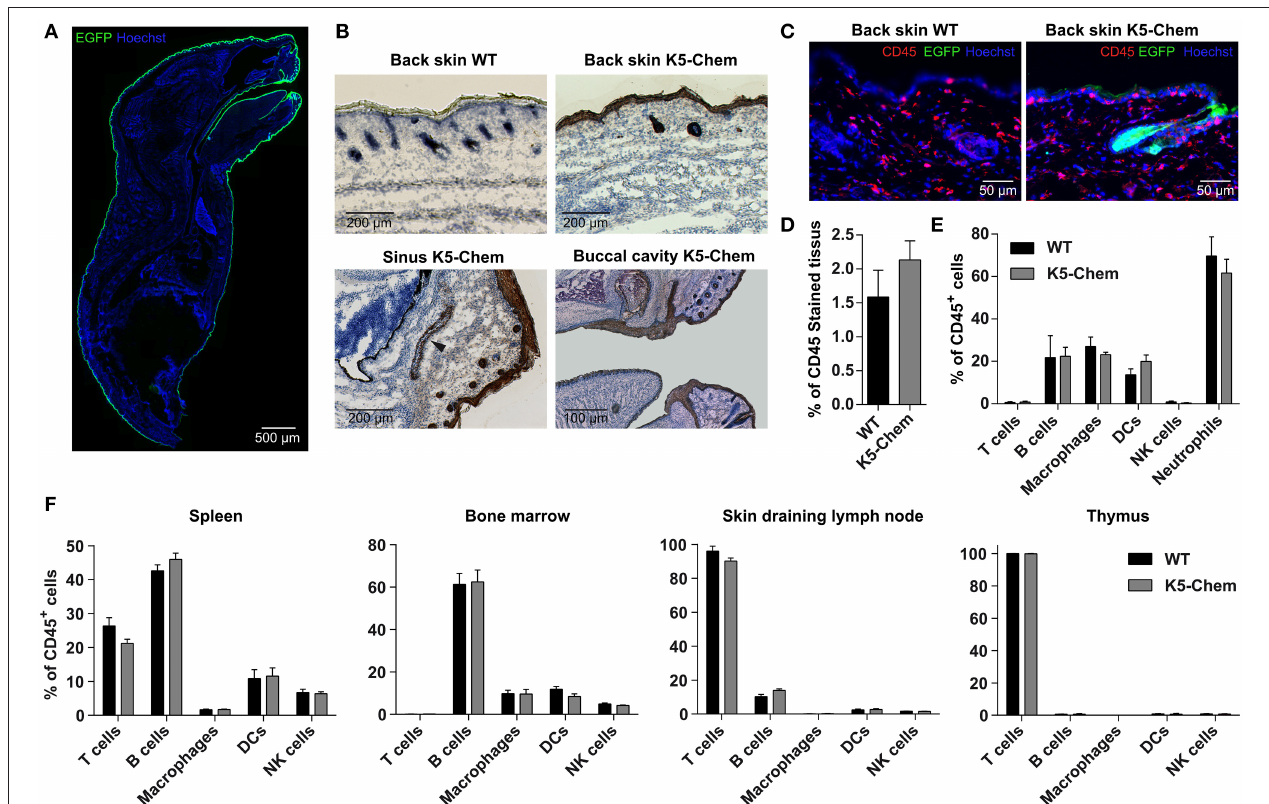
FIGURE 3 | Overexpression of bioactive chemerin in skin does not affect leukocyte populations in skin and lymphoid organs. (A,B) Whole newborn mice were pre-fixed for 48h in 4% paraformaldehyde, embedded in OCT and sagittal sections were made. (A) Reconstitution of a sagittal section of a K5-chemerin mouse, with EGFP intrinsic fluorescence in green and cell nuclei stained in blue (Hoechst). (B) Cryosections were stained by immunohistochemistry for EGFP (brown) and counter-stained by hematoxylin-eosin. Upper panels show the back skin of control (left) and K5-chemerin (right) mice. Lower panels illustrate sections through sinus cavities (left) and a partial reconstitution of the buccal cavity (right) of K5-chemerin mice. Black arrowhead indicates the location of the sinus. (C) Skin cryosections from control (left) and K5-chemerin (right) mice showing CD45 staining (red), EGFP fluorescence (green), and nuclei (Hoechst, blue). (D) The relative surface of CD45 + staining in skin sections was measured and graphed (mean ± SEM, n = 5 mice per group). (E,F) Skin samples (E) , thymus, skin draining lymph nodes, bone marrow and spleen (F) were collected from control and K5-chemerin mice and digested. The cell suspensions were stained with combinations of antibodies and analyzed by flow cytometry. The percentage of CD45 + cells and the proportion of various leukocyte subsets (% of CD45 + cells) are represented, including T cells (CD3 + CD4 + and CD3 + CD8 + ), B cells (CD3 − B220 + ), neutrophils (Ly6G + CD11b + ) macrophages (CD11b + CD11c − ), DCs (CD11c + ) and NK cells (CD3 − NK1.1 + ). The results are from a representative experiment (mean ± SEM, n = 5 mice per